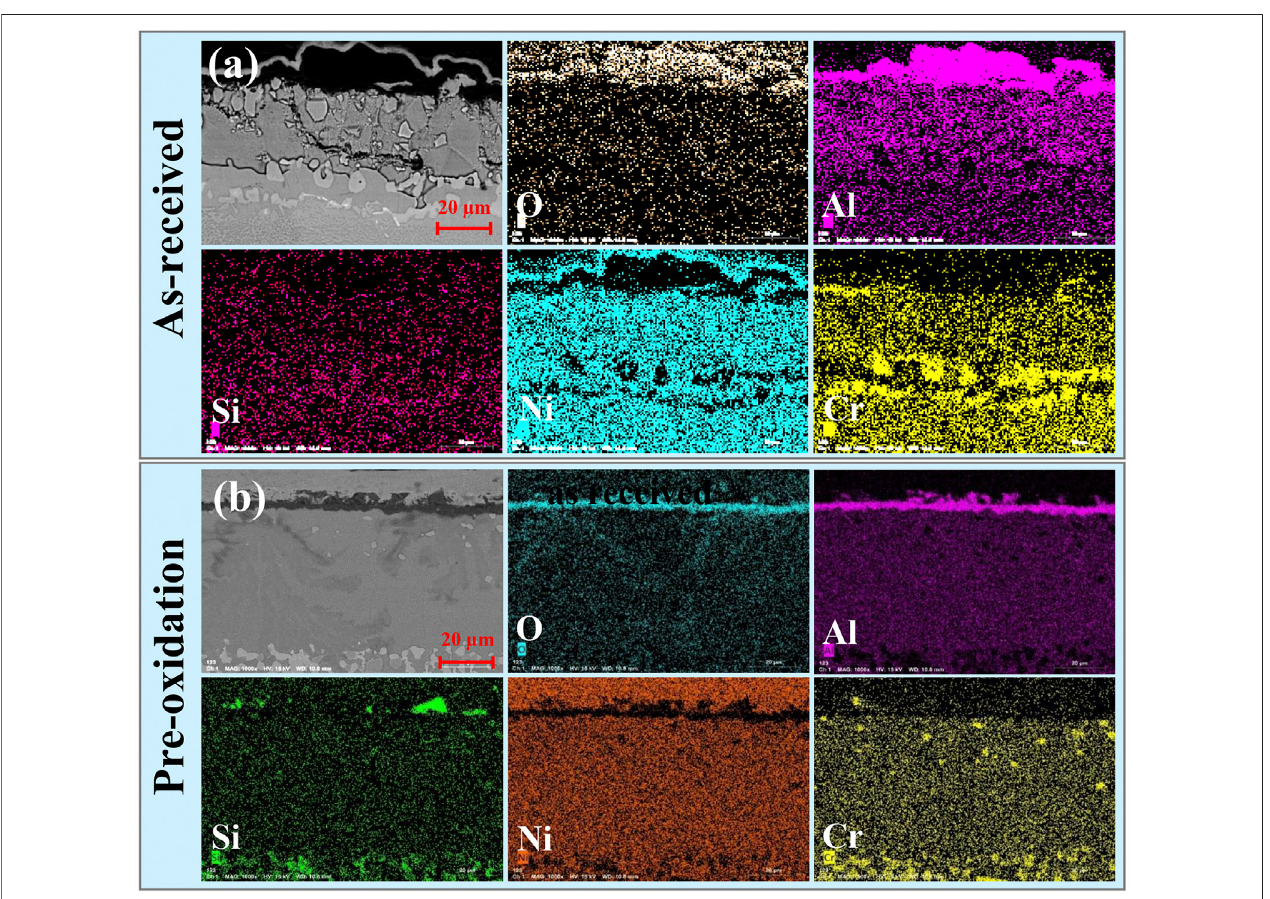
FIGURE 5 | EDS mapping of the aluminide coating cross section after hot corrosion for 120 h in Na 2 SO 4 salt at 1050 ° C for (A) as-received and (B) pre-oxidation.